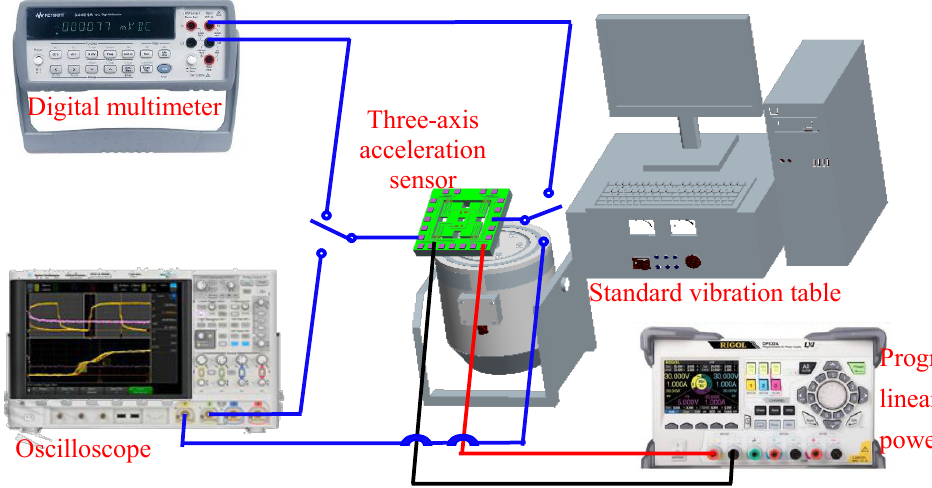
Figure 7. The test system of the three-axis acceleration sensor.